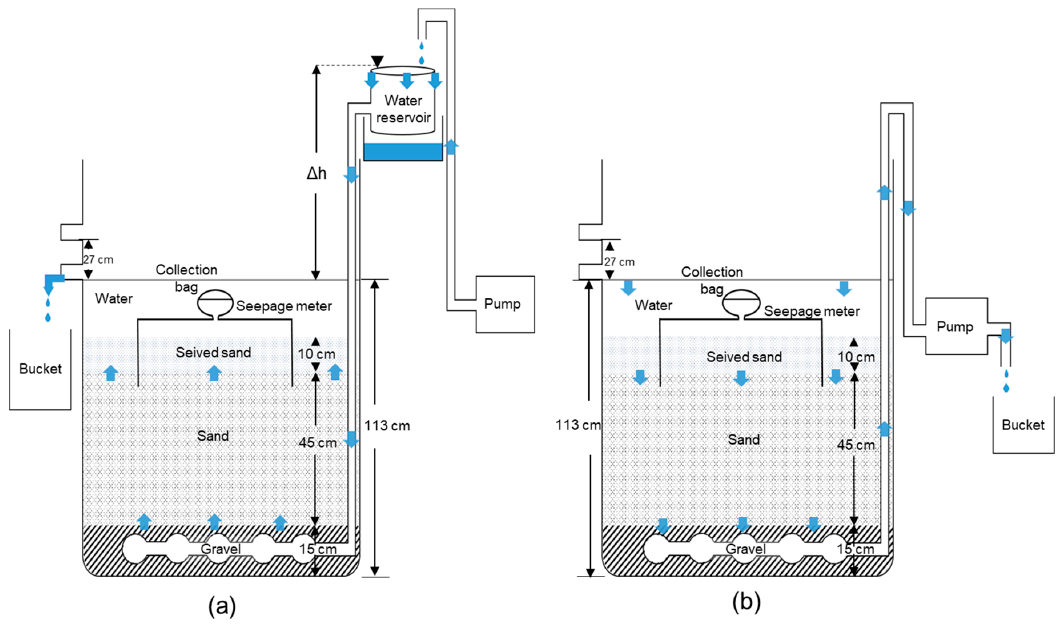
Figure 3. Schematics of ( a ) the influx measurement experiment and ( b ) the outflux measurement experiment.